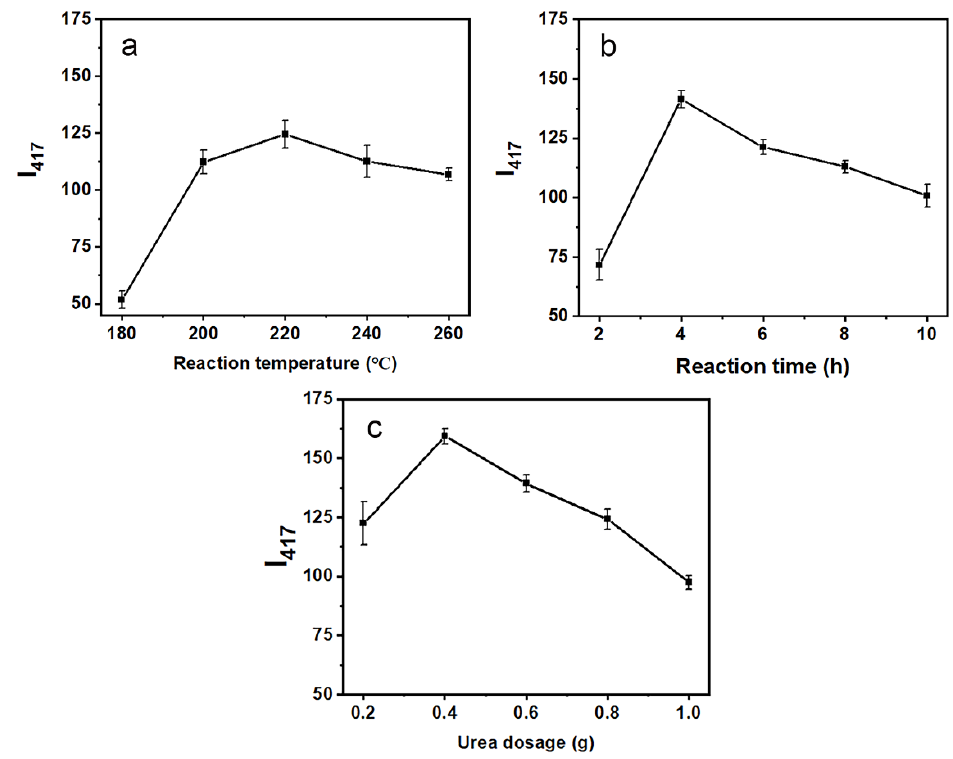
Figure 1. Variations in the emission intensities at 417 nm of the N-CQD solutions (80 mg/L) under different reaction temperatures ( a ) 2 – 10 h, reaction times ( b ) 180 – 260 °C, and urea dosages ( c ) 0.2 – 0.6 g.